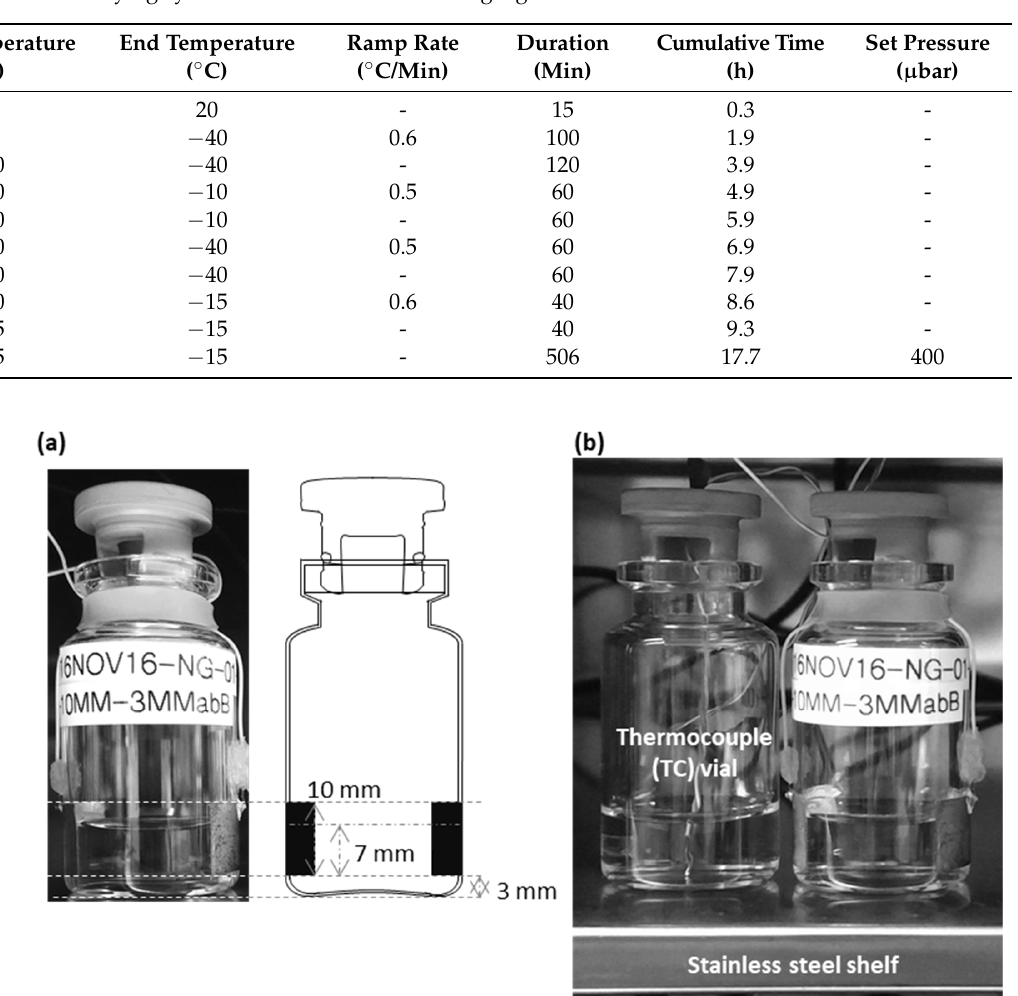
Figure 1. ( a ) TVIS vial containing 3 g of double distilled water, with copper electrodes (10 mm by 19 mm) positioned at 3 mm from the vial base; ( b ) TVIS vial and a type T thermocouple containing vial, each filled with 3 g of double-distilled water and placed at the front of the shelf of a Virtis Advantage Plus lab-scale dryer.